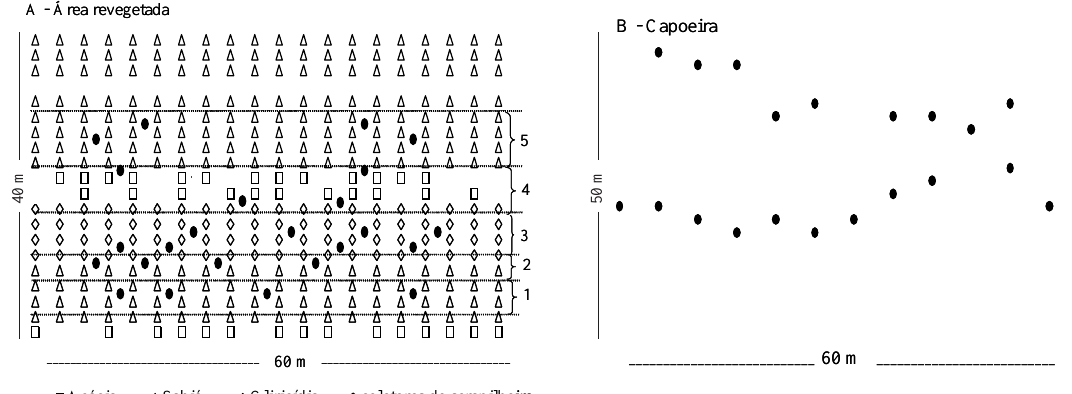
Figura 2. Esquema mostrando a distribuição de coletores de serapilheira na área revegetada (a) e na capoeira vizinha (b). Os números indicam as faixas estudadas na revegetação, em que: 1 - Mc1 = faixa com predomínio de Mimosa caesalpiniifolia (sabiá); 2 - Mc/Gs = faixa com Mimosa caesalpiniifolia e Gliricidia sepium (gliricídia); 3 - faixa com predomínio de Gliricidia sepium ; 4 - faixa com